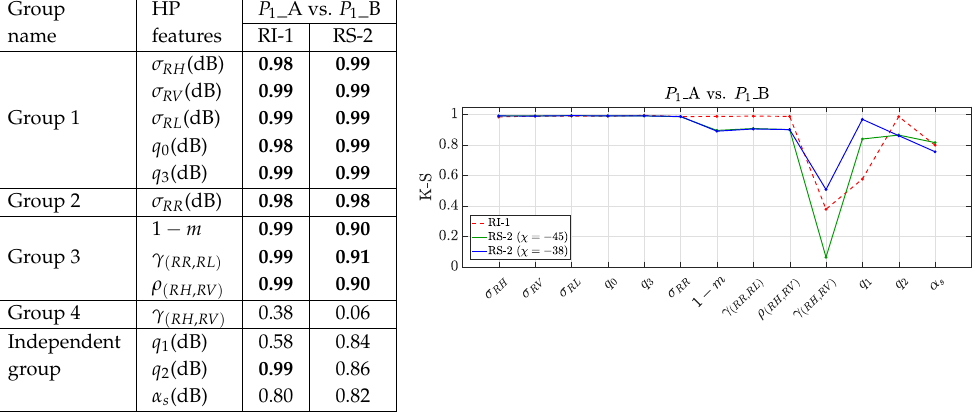
Figure 7. Left panel; a table containing the Kolmogorov-Smirnov (K-S) separability values between the two sea ice types in P 1 . The first column shows the groups as described in Table 3. The values greater than 0.9 are in bold. Right panel; the corresponding values are shown in the plot for the two sea ice types, where the y-axis shows the K-S values calculated for the two sea ice types (i.e., ROIs) (red for the RI-1 features and green (blue) for the RS-2 features with an ellipticity angle of χ = − 45 ◦ ( − 38 ◦ )), while the x-axis shows the corresponding features. Note that only the K-S values for RI-1 features and the RS-2 features using an ellipticity angle of χ = − 45 ◦ is shown in the